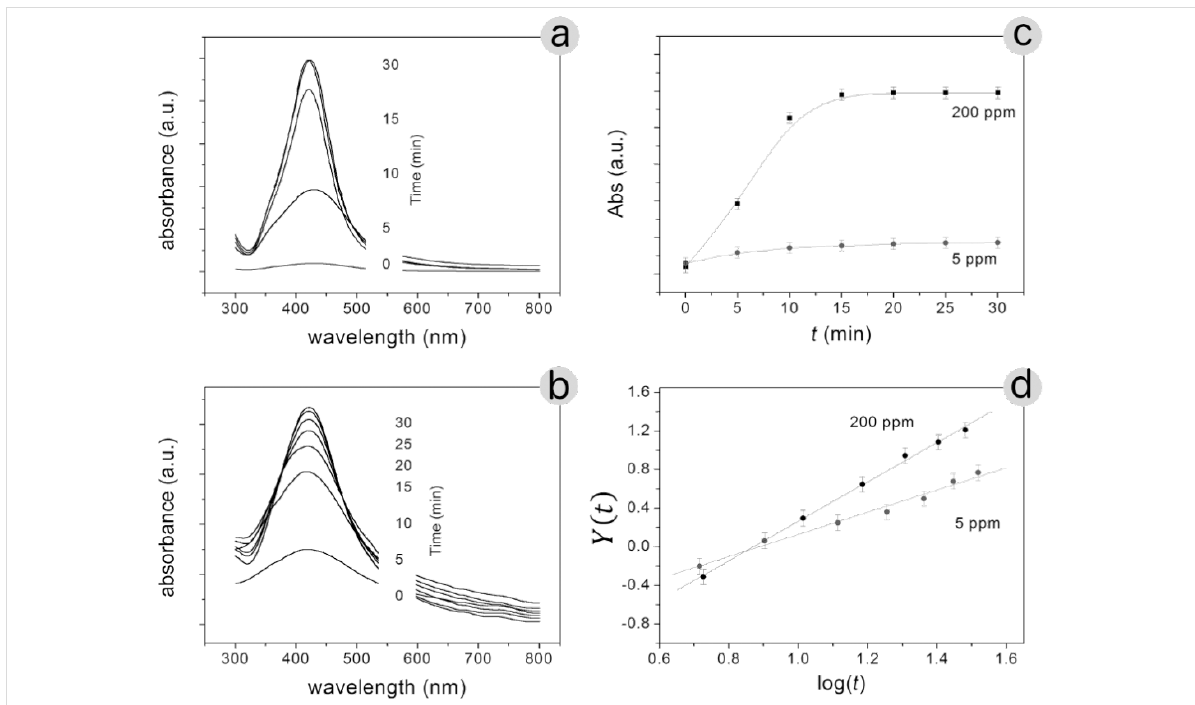
Figure 6: UV–vis absorption spectra recorded as a function of the reaction time with (a) 200 ppm and (b) 5 ppm ammonia; (c) SPR intensity (Abs) as a function of the reaction time; (d) experimental values of Y ( t ) = log{ln[abs ∞ /(abs ∞ − abs( t )]} plotted and fitted according to Equation 3.